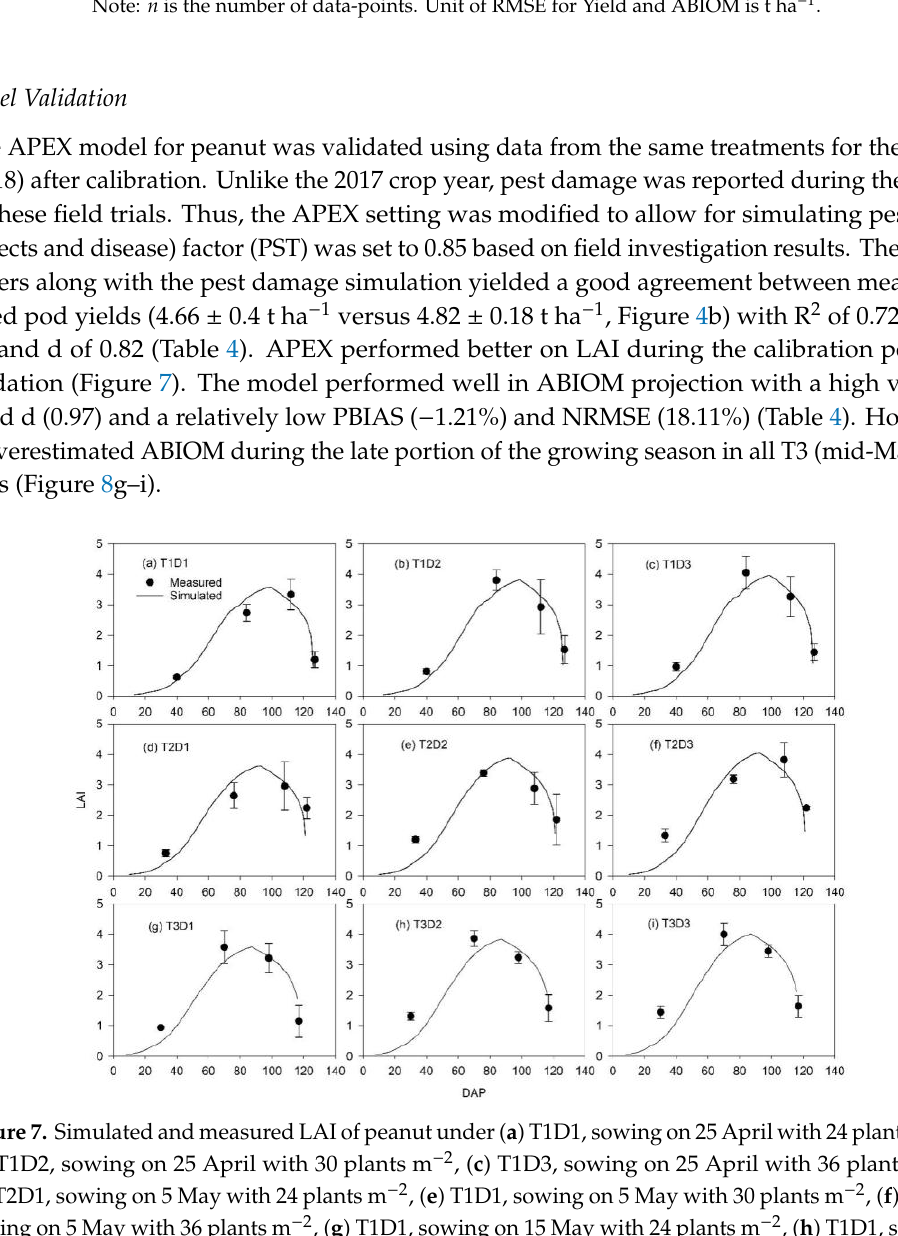
Figure 7. Simulated and measured LAI of peanut under ( a ) T1D1, sowing on 25 April with 24 plants m